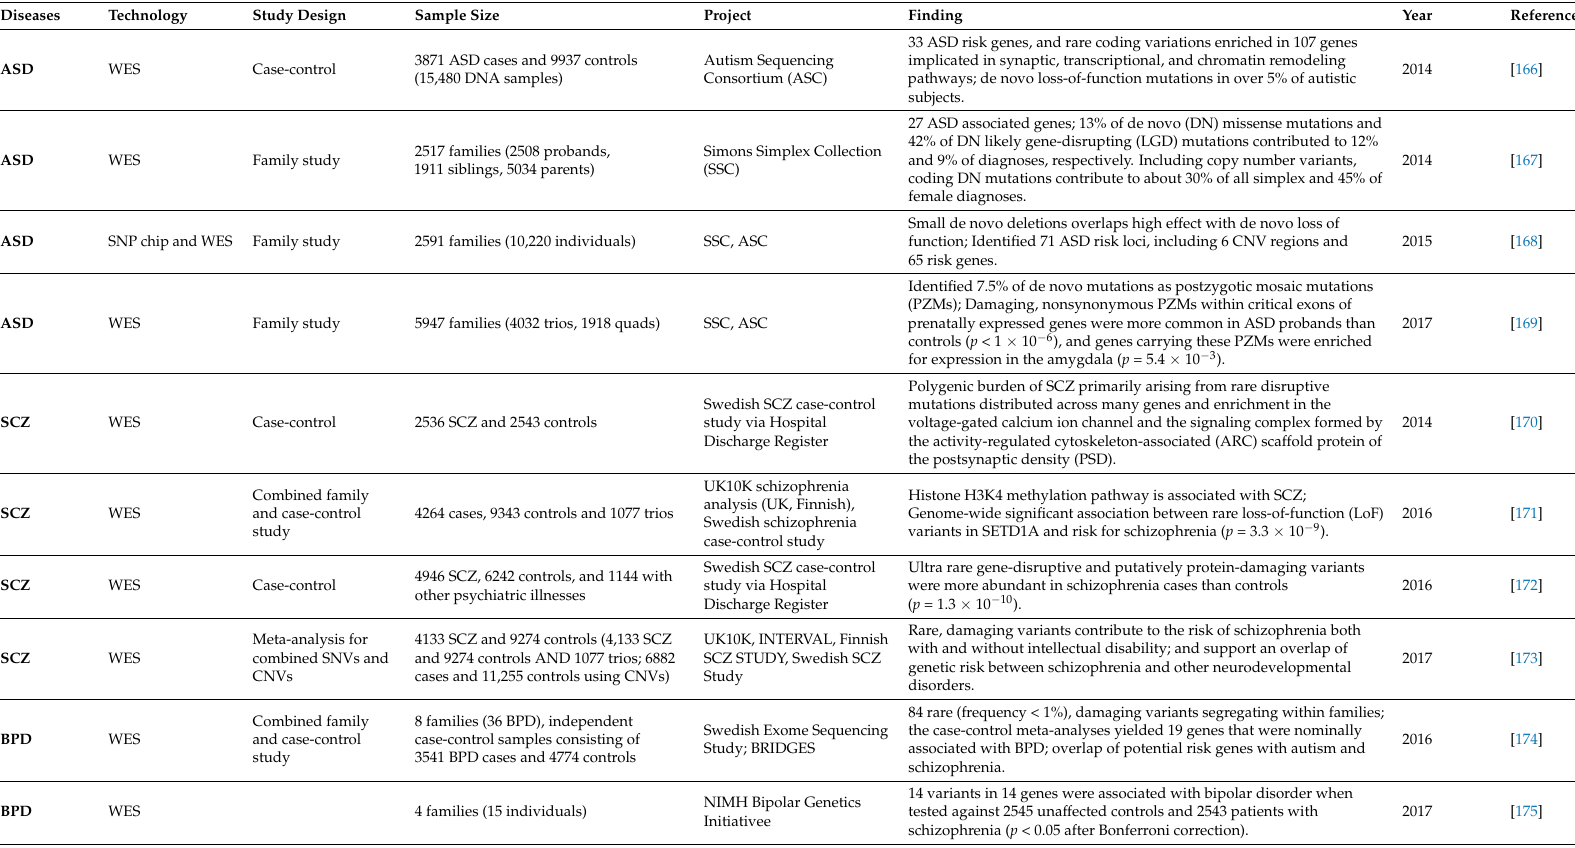
Table 5. Main whole exome sequencing/whole genome sequencing (WES/WGS) findings in major psychiatric disorders.